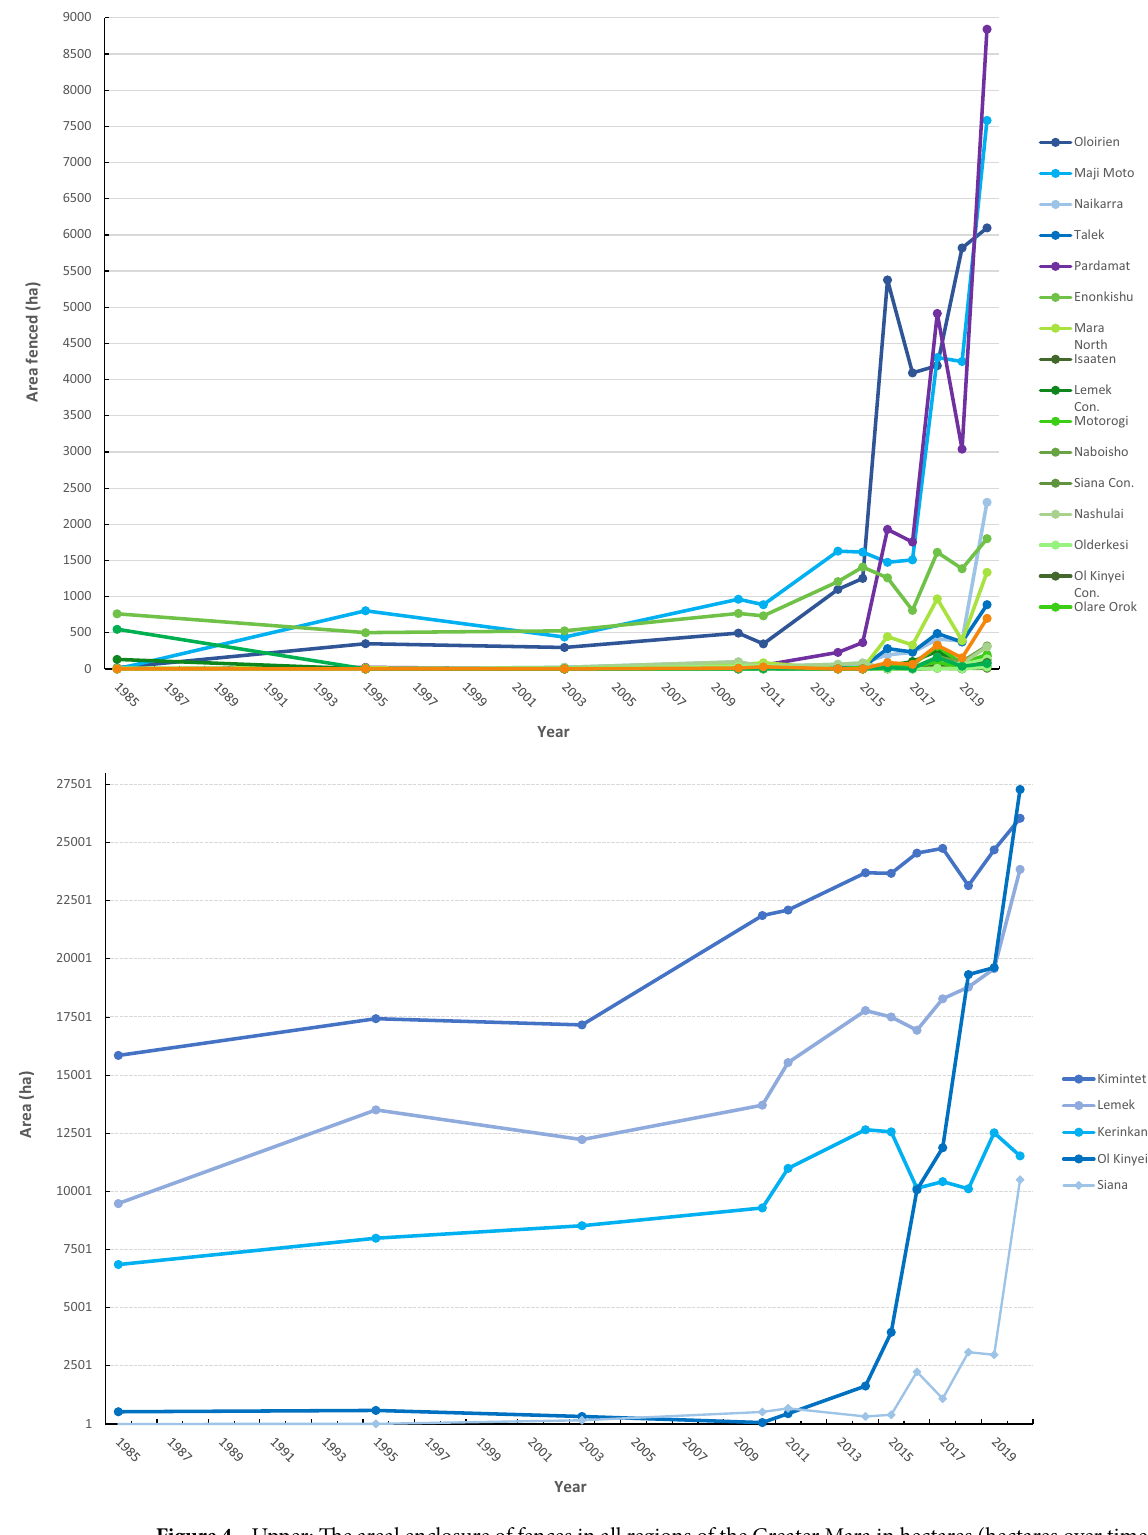
Figure 4. Upper: The areal enclosure of fences in all regions of the Greater Mara in hectares (hectares over time from 1985 to 2020). To illustrate the differences in areal enclosure between the four types of protected land, regions of the type have been assigned the same color ranges. Orange: National Reserve; purple: Conservation Area; green: Conservancy; blue: Remaining land. Lower: The five most fenced regions (cf. formally unprotected land) are illustrated to make it easier to read graph